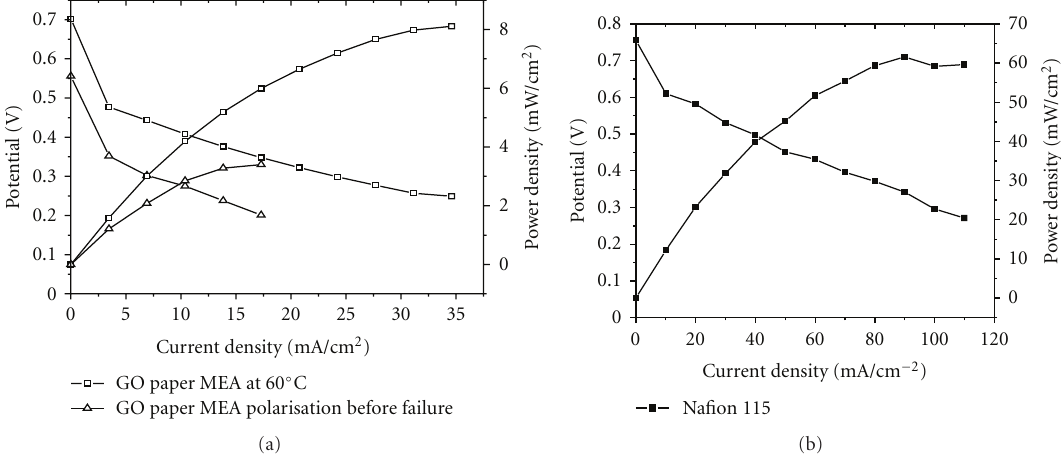
Figure 8: (a) Polarization curves of GO paper MEA at scan rate of 5 mVs − 1 for direct methanol fuel cell 1M methanol (flow rate 3cc min − 1 ) and oxygen (flow rate 400cc min − 1 ) at 60 ◦ C. (b) Polarization curves of Nafion 115 MEA at 5mVs − 1 for direct methanol fuel cell 1M methanol (flow rate 3 cc min − 1 ) and oxygen (flow rate 400cc min − 1 ) at 60 ◦